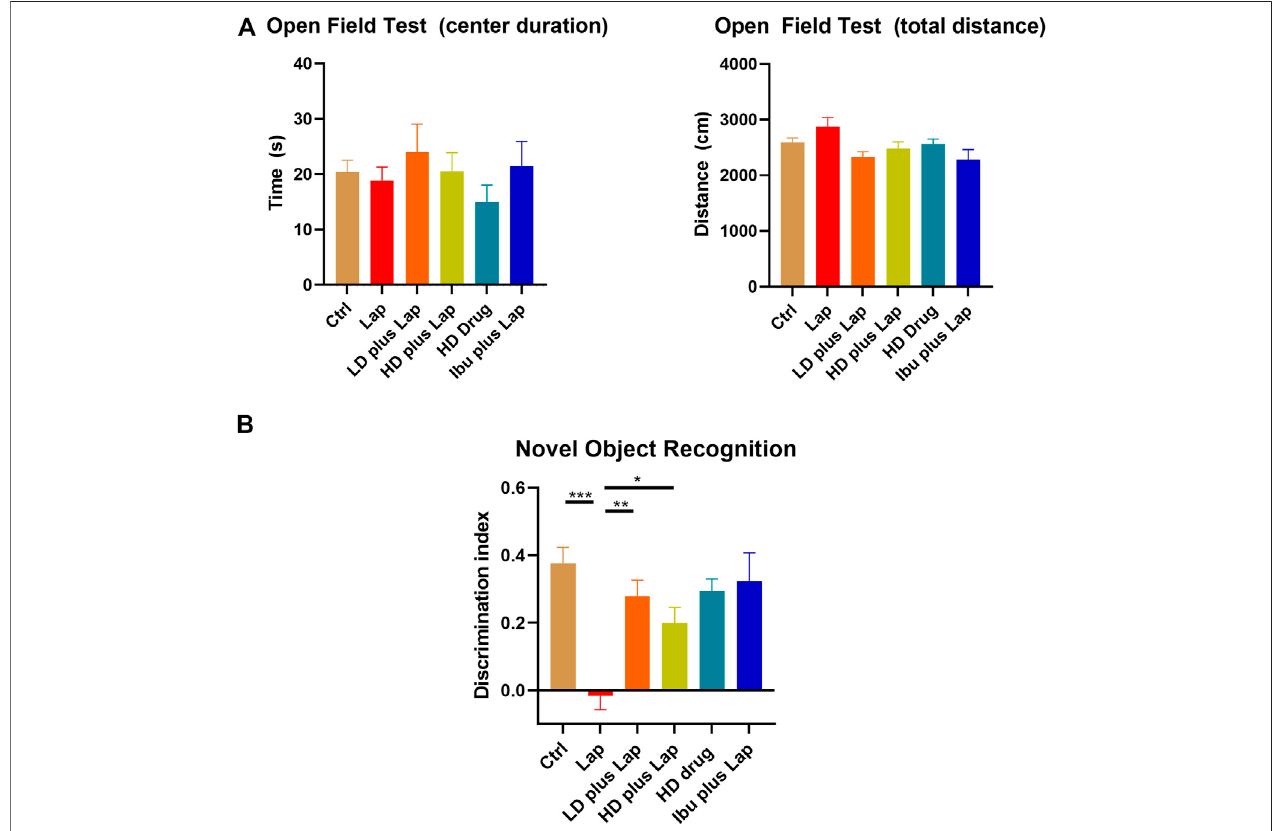
FIGURE 4 | D101 treatment improved cognitive function in postoperative animals. (A) Open fi eld test on POD 1. No signi fi cant anxiety was observed in all animal groups. (B) Novel object recognition test on POD 3. Signi fi cant increase in the discrimination index was shown in laparotomy group after D101 treatment. Data are presented as the mean and SEM ( n = 5 – 6). * p < 0.05, ** p < 0.01, *** p < 0.001 compared with the laparotomy group. Values were analyzed by one-way ANOVA with Tukey post hoc